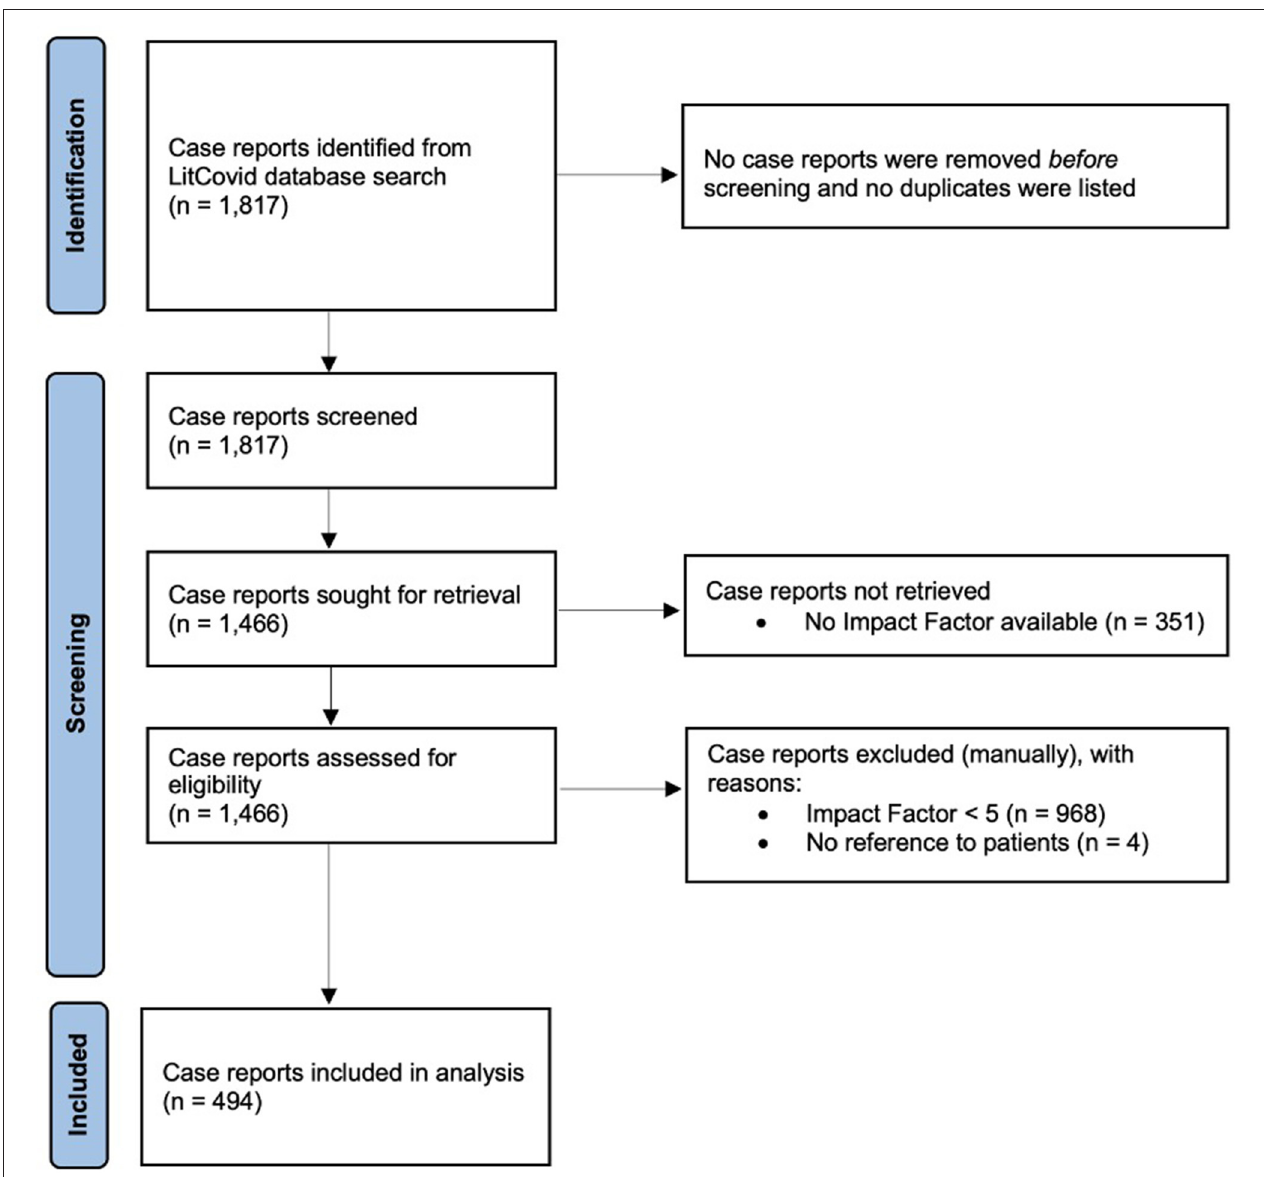
FIGURE 1 | Study flow diagram of the identification and screening of eligible Covid-19-related case reports retrieved from the PubMed LitCovid